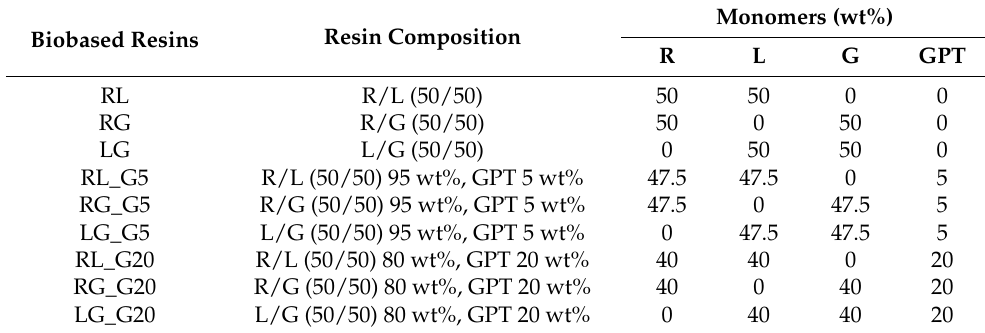
Table 1. Resin composition of biobased acrylates for wood coating application. Biobased